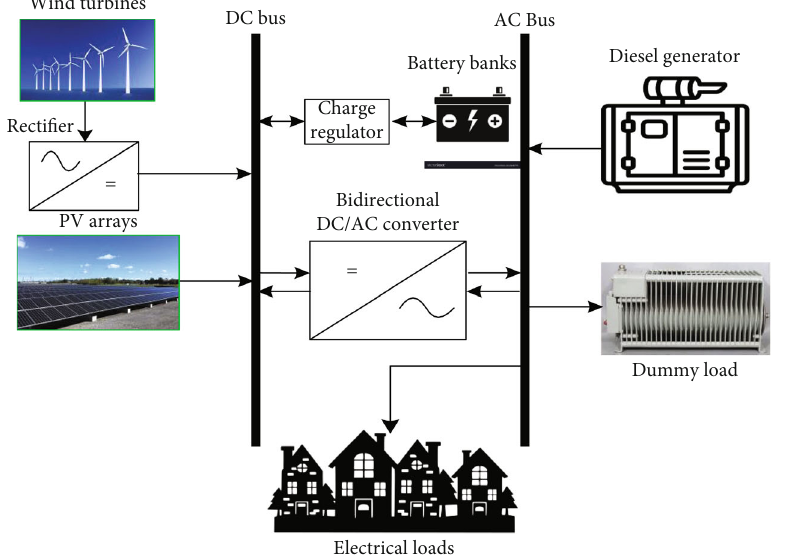
Figure 1: Con fi guration of the proposed PV-WT-diesel-battery